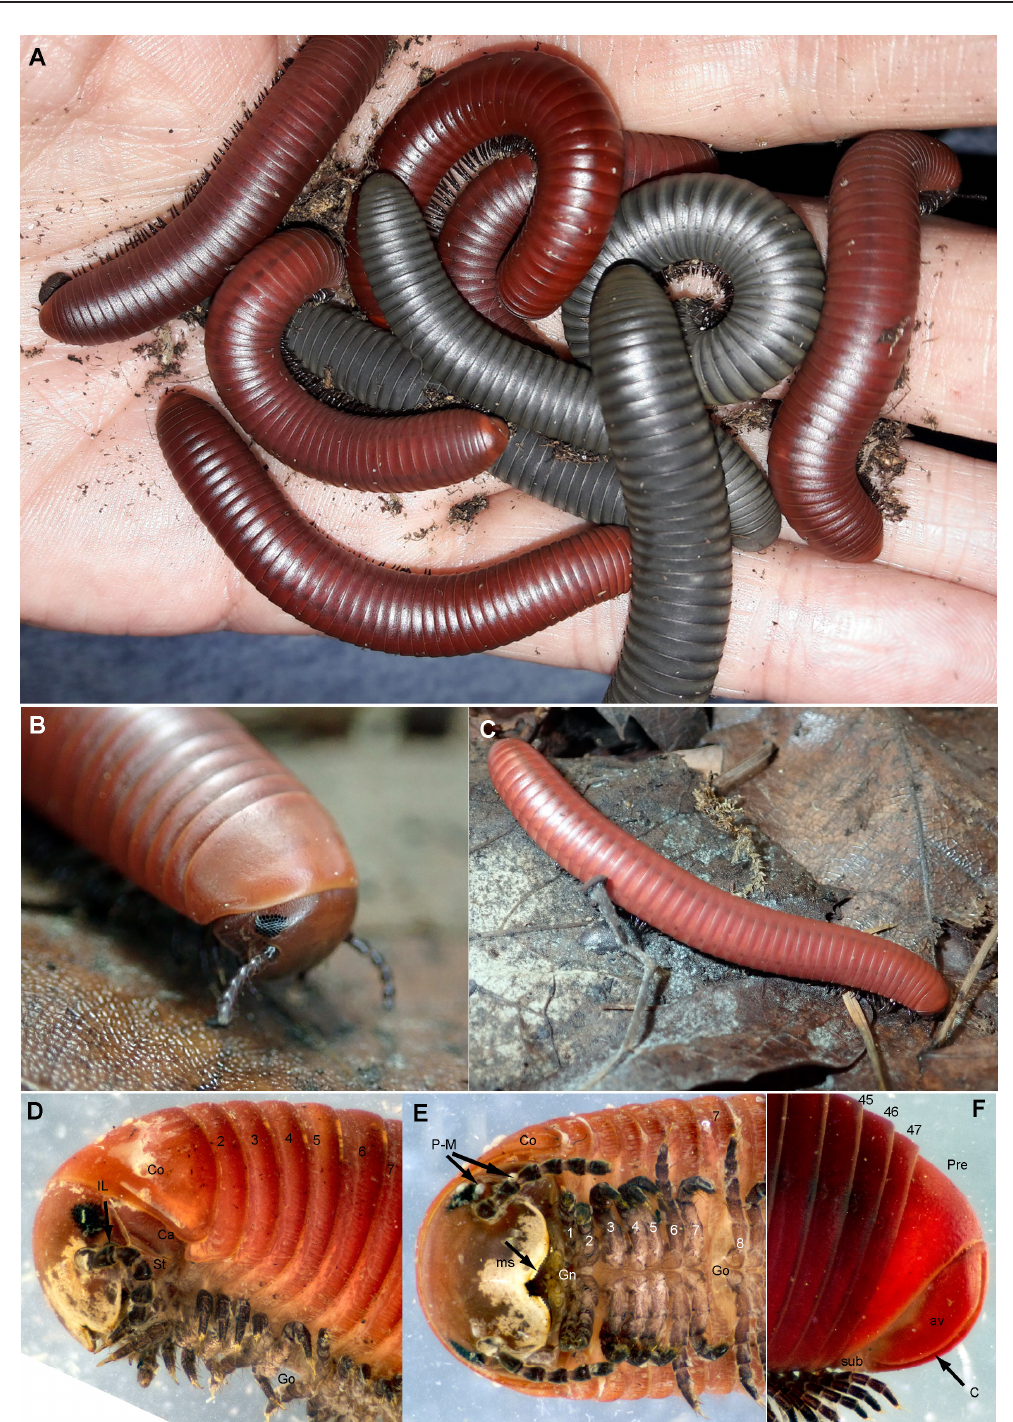
Fig. 1. Dichromatobolus elephantulus gen. et sp. nov. A . Living ♂ (red; FMNH-INS 55888) and ♀ (grey; FMNH-INS 55887) from Odenwald Exoten 2007 import, photo by P. Decker. B – C . Living immature ♂, 2019 import (ZFMK MYR8708), photo by L. Moritz. B . Head. C . Whole body. D – F . ♂ (ZFMK MYR8745), multi-layer photographs. D . Anterior body, lateral view; E . Leg pairs 1–7, ventral view. F . Posterior body end with telson. Abbreviations: av = paraprocts; C = lips of paraprocts; Ca = cardines; Co = collum (ring 1); Gn = gnathochilarium; Go = gonopods; IL = incisura lateralis; ms = marginal setae; P-M = parasitic(?) mites; Pre = epiproct; St = stipes; sub = hypoproct. Not to